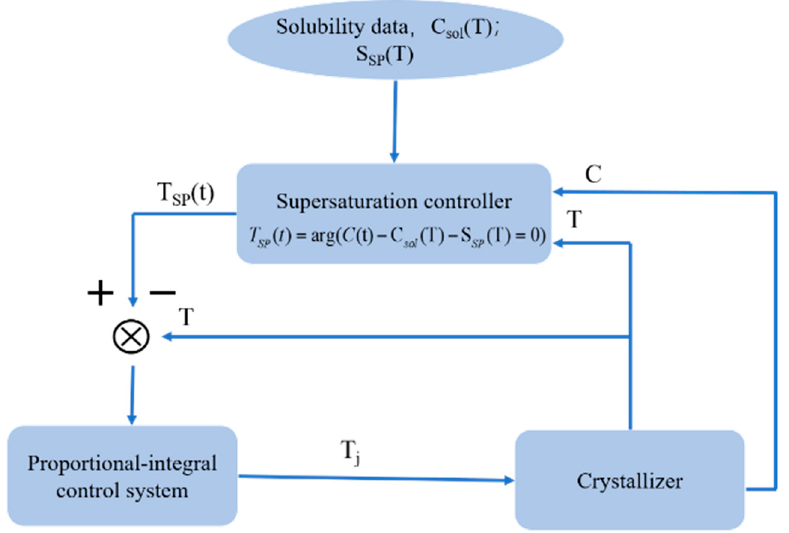
Figure 2. Generic block diagram of concentration feedback control approach.